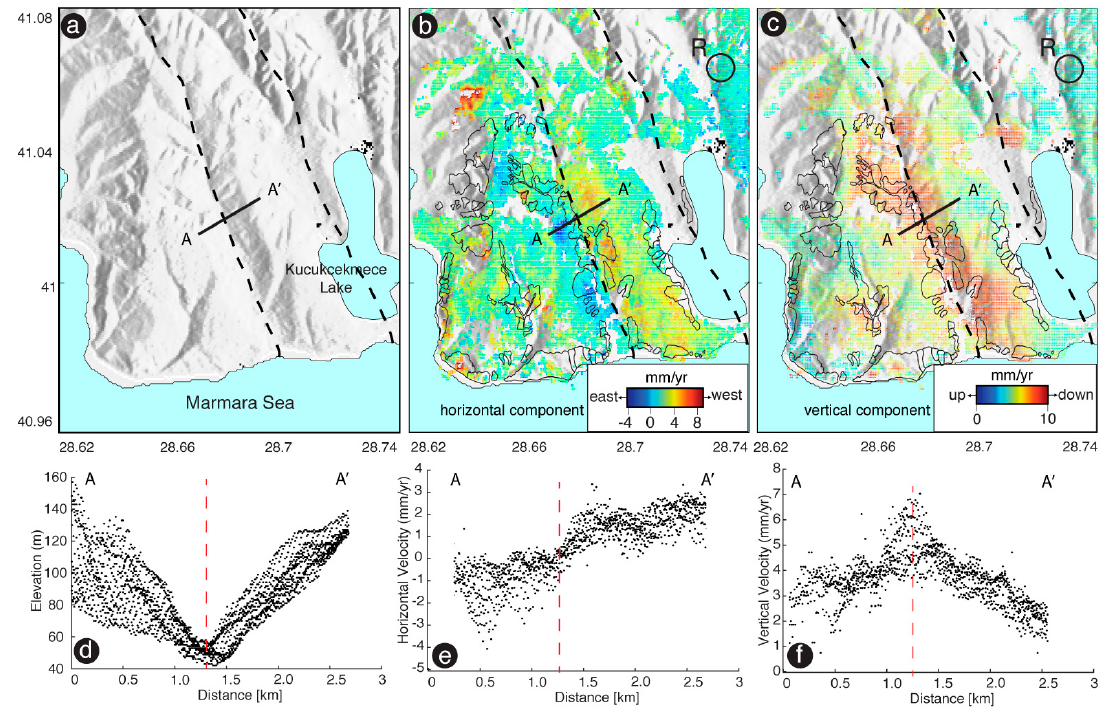
Figure 7. Decomposition of horizontal and vertical components of ground displacement using only S-1 datasets. ( a ) The shaded topography was given by the Shuttle Radar Topography Mission (SRTM) along the Avcilar region. Fault lines were simplified from Ergintav et al. [37]; ( b ) Vertical component. Patches with thick dark boundaries correspond to the landslides that were identified geological maps, as shown on Figure 2 [simplified from Duman et al. and Ozgul et al. [38,39]; ( c ) Horizontal component in the east–west direction. ( d )Valley-perpendicular elevation profile extracted from ( a ); ( e , f ) are horizontal and vertical velocity profiles extracted from ( b , c ) respectively.